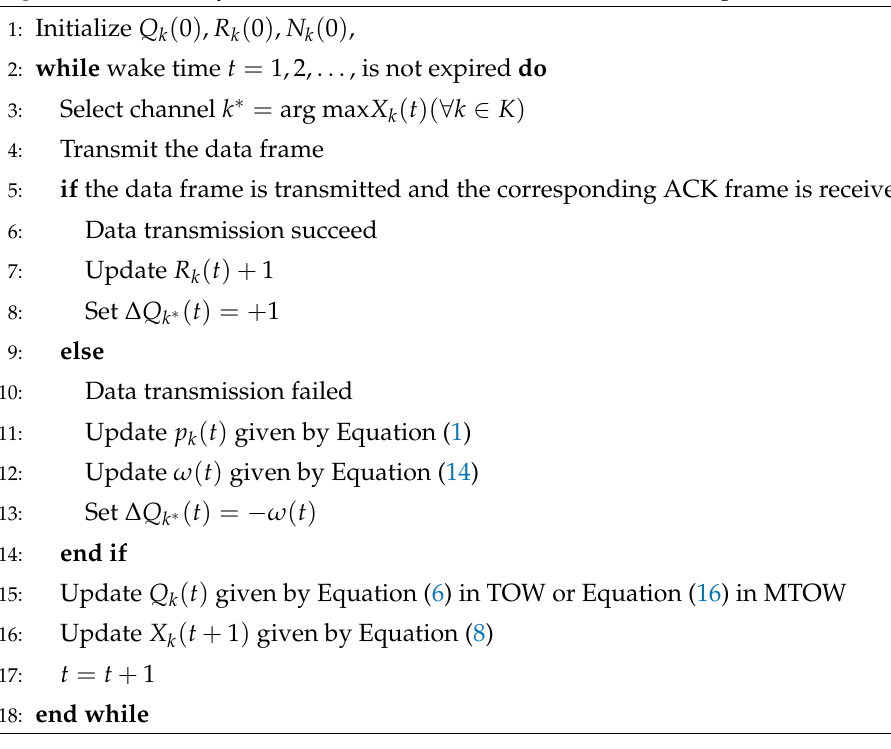
Algorithm 3 TOW dynamics or MTOW-based channel selection